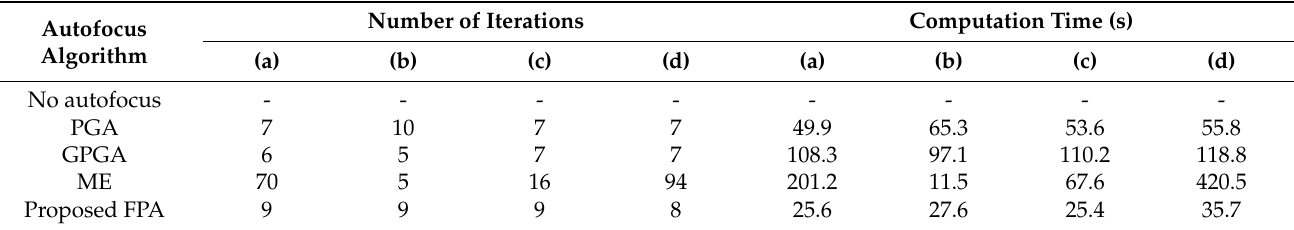
Table 7. Comparison of the number of iterations and computation time for different autofocus algorithms for scene